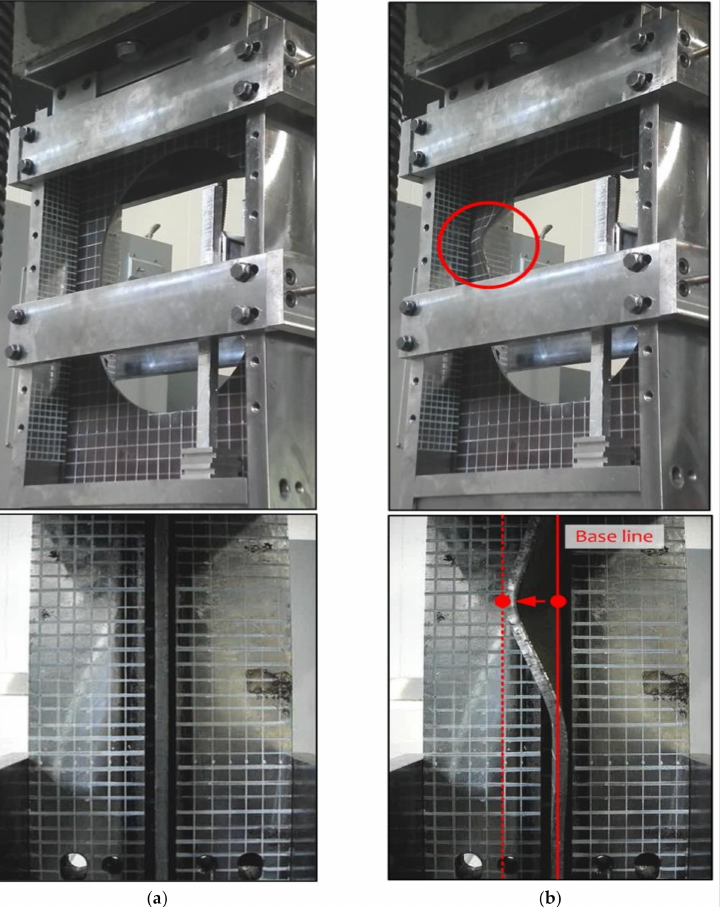
Figure 9. Changes in lateral deflection of the perforated plates: ( a ) initial and ( b ) deformed conditions.